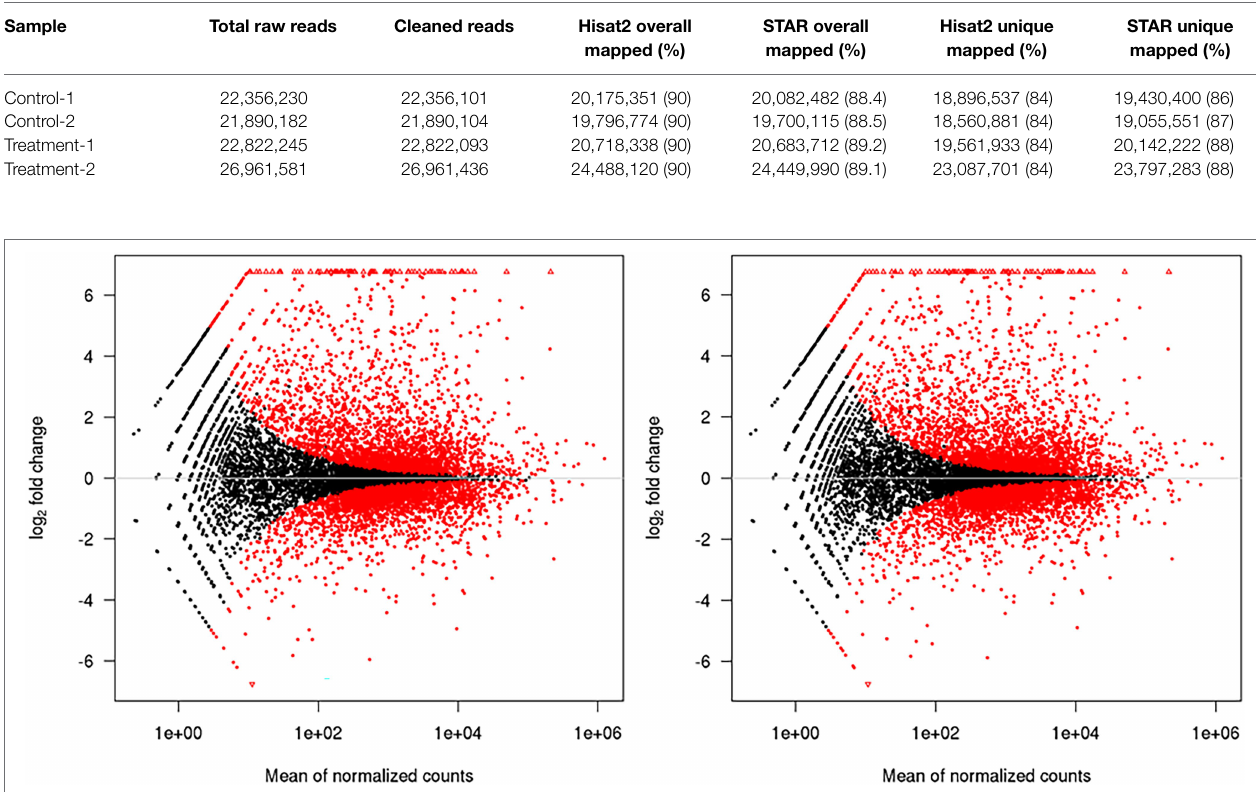
STAR overall Hisat2 unique STAR unique mapped (%) mapped (%) mapped (%) mapped